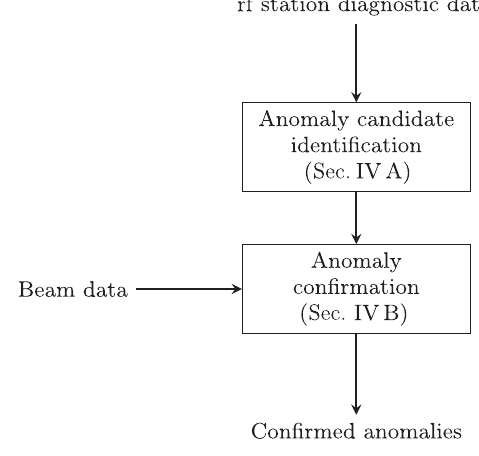
FIG. 2. Two-stage rf station anomaly identification